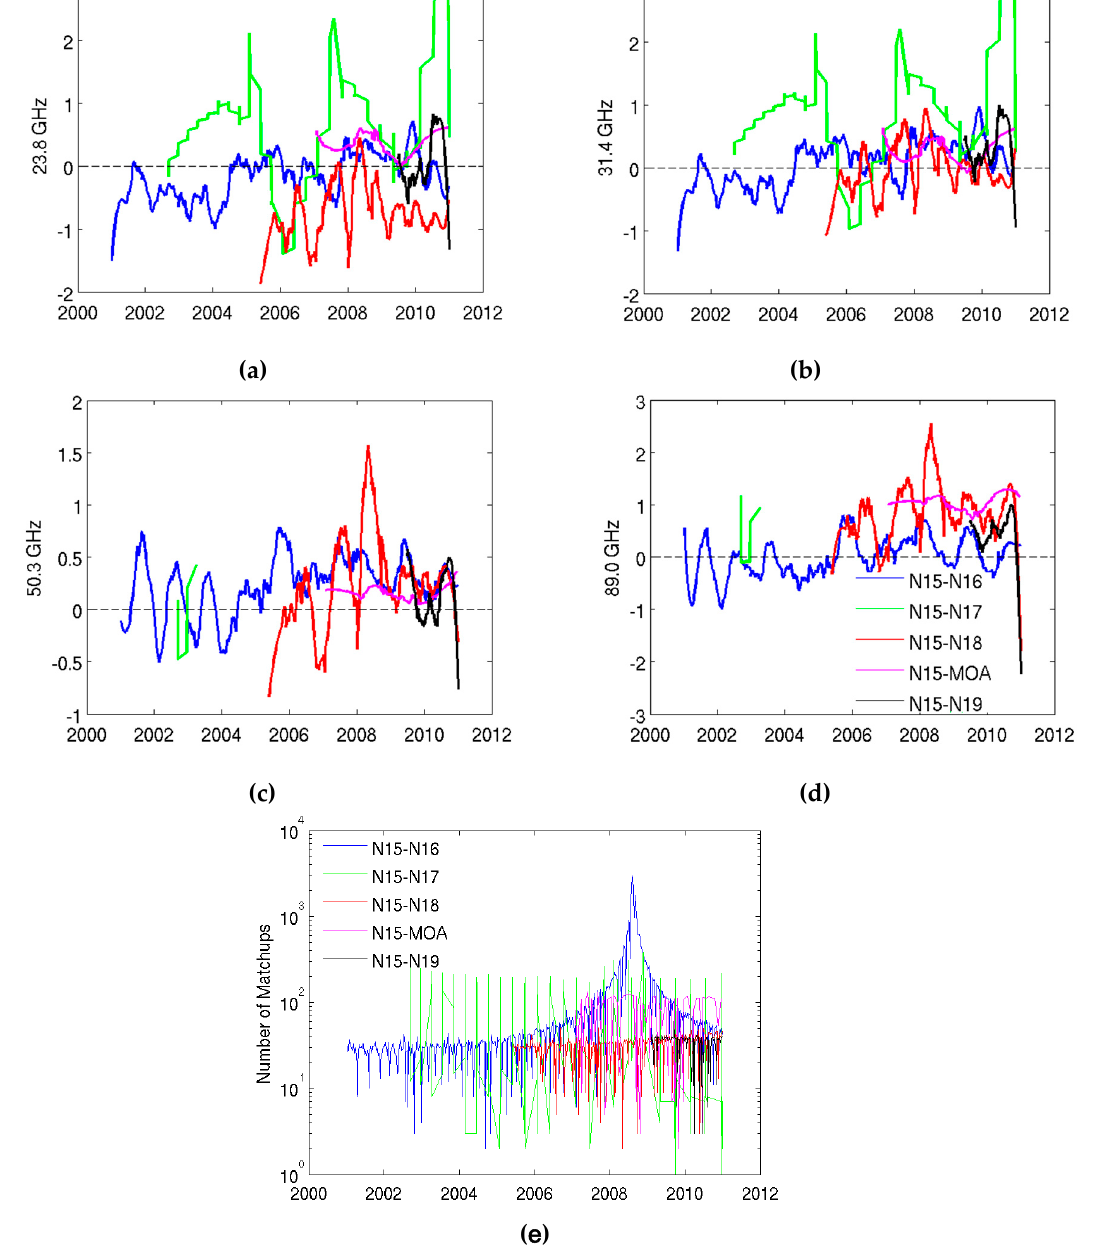
Figure 2. Smoothed brightness temperature differences of SNO pairs between AMSU-A onboard N15 with N16 through N19 and MetOP-A, from their operational time till the end of 2010 for ( a ) 23.8, ( b ) 31.4, ( c ) 50.3 and ( d ) 89 GHz. The typical uncertainty on the difference is about the same order of the difference. ( e ) Shows number of SNO matchups between N15 and other satellites, in the logarithm scale.